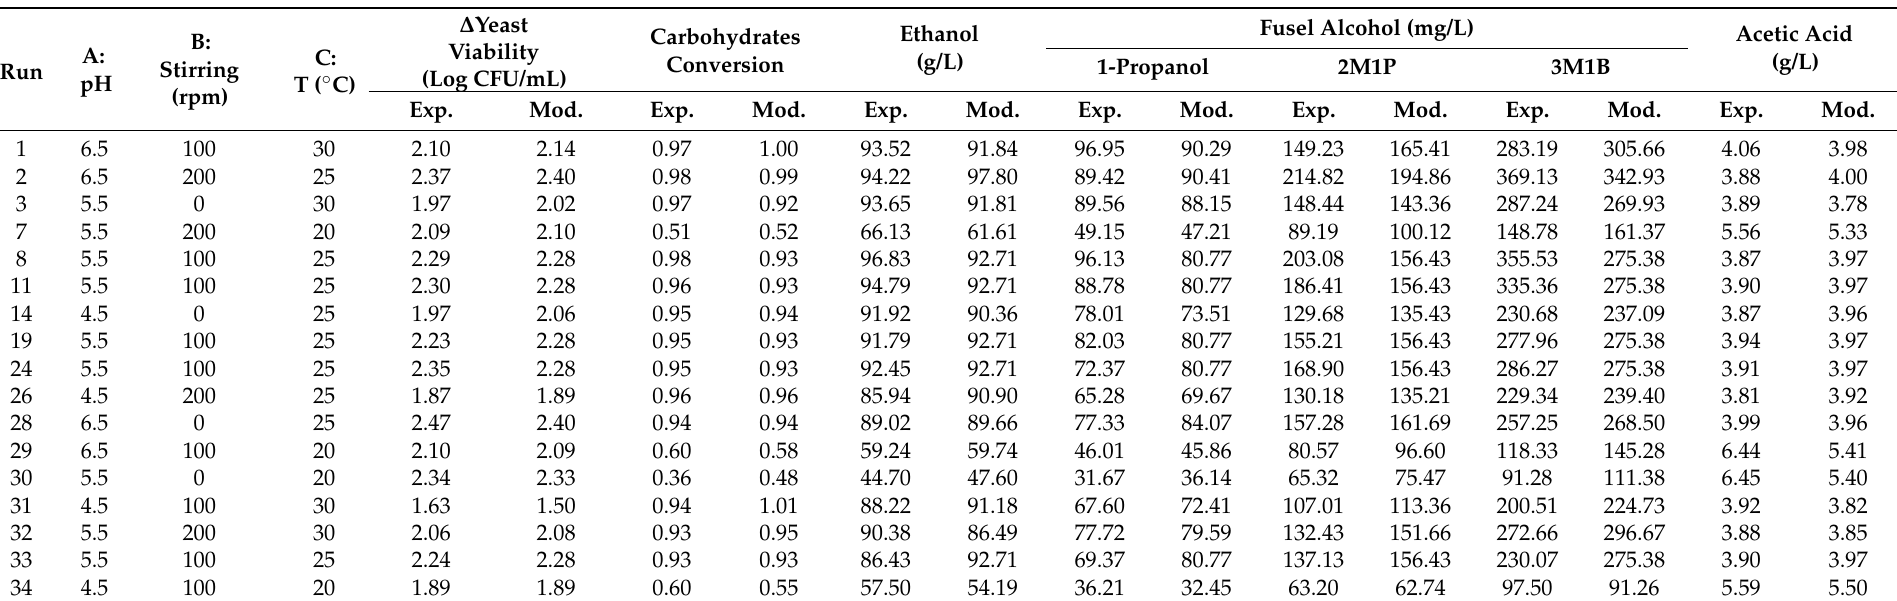
Table 2. Experimental design for the effect of fermentation factors such as pH (A), stirring (B), and temperature (C) over the final change in yeast viability (Log CFU/mL), carbohydrates conversion, ethanol (g/L), 1-propanol (mg/L), 2-methyl-1-propanol (mg/L), 3-methyl-1-butanol (mg/L), and acetic acid (g/L) concentration after 24 h fermentation of